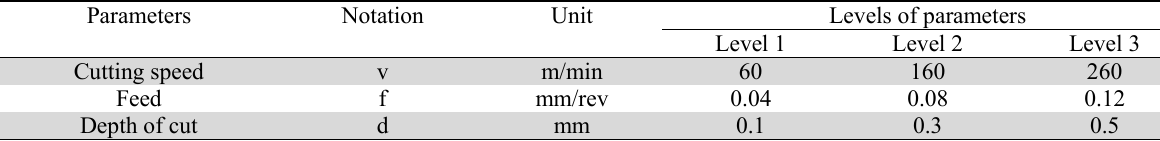
Process parameters and their levels Parameters